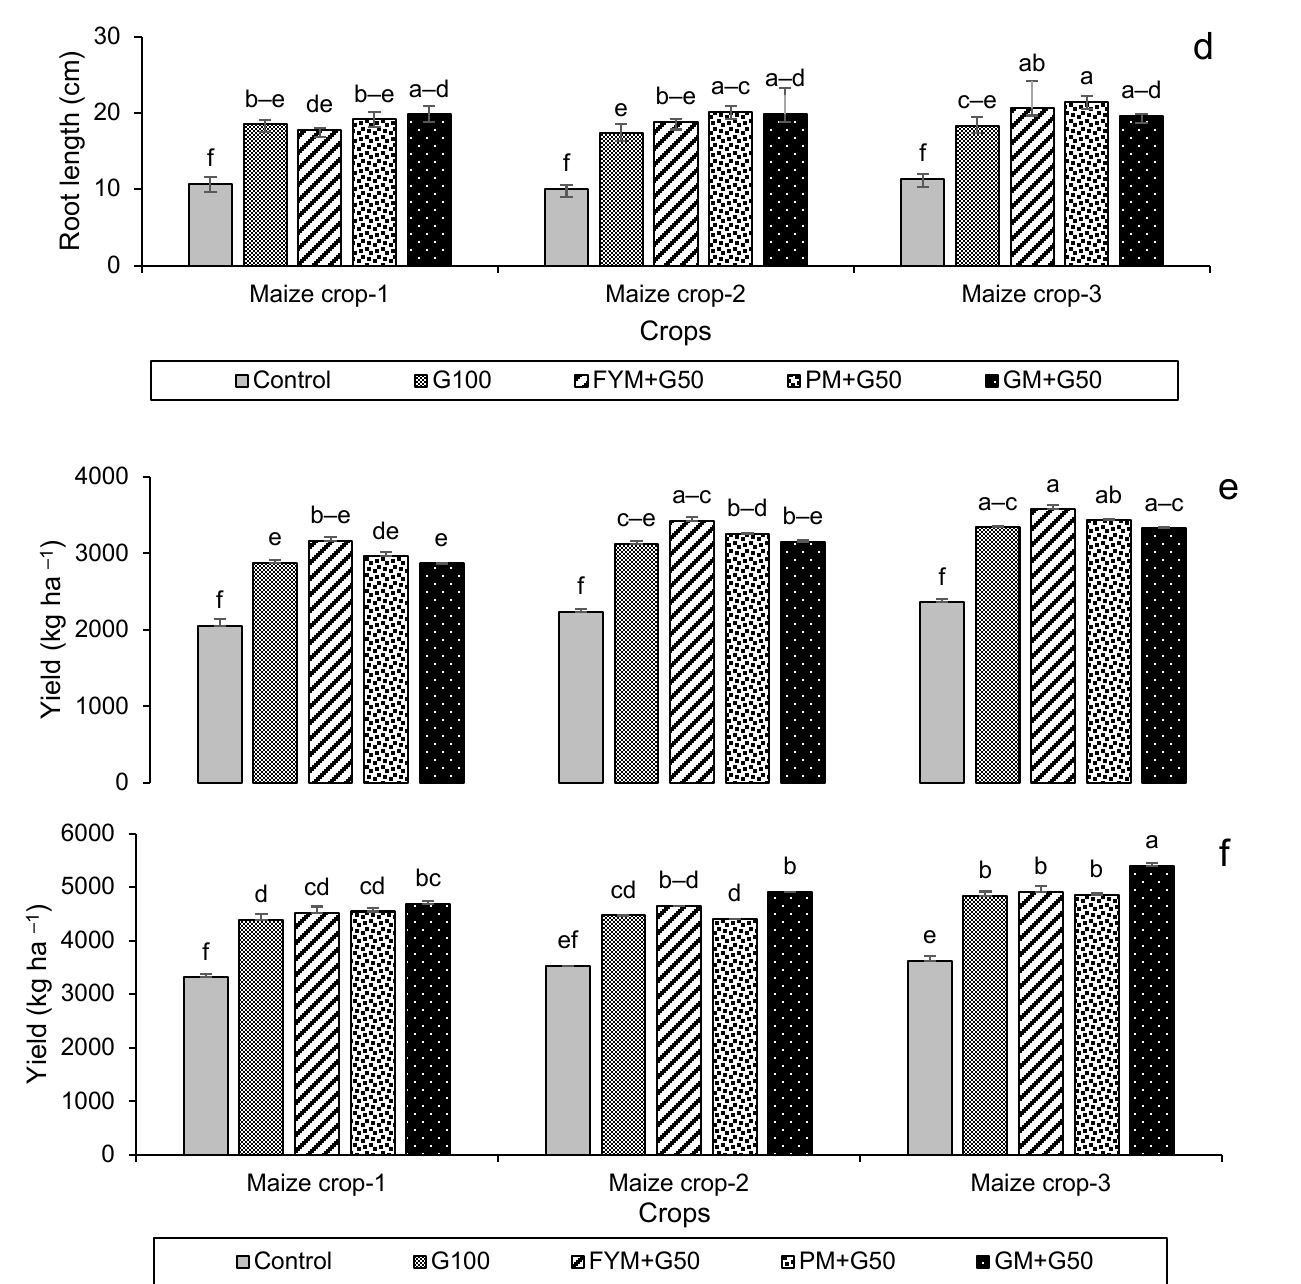
Figure 6. Impacts of different treatments on ( a ) leaf, ( b ) shoot, and ( c ) root fresh and dry weights, ( d ) root length of maize, ( e ) yield of wheat and ( f ) yield of maize. Error bars represent the standard error ( n = 3). Different letters indicate statistical difference (LSD, p < 0.05).